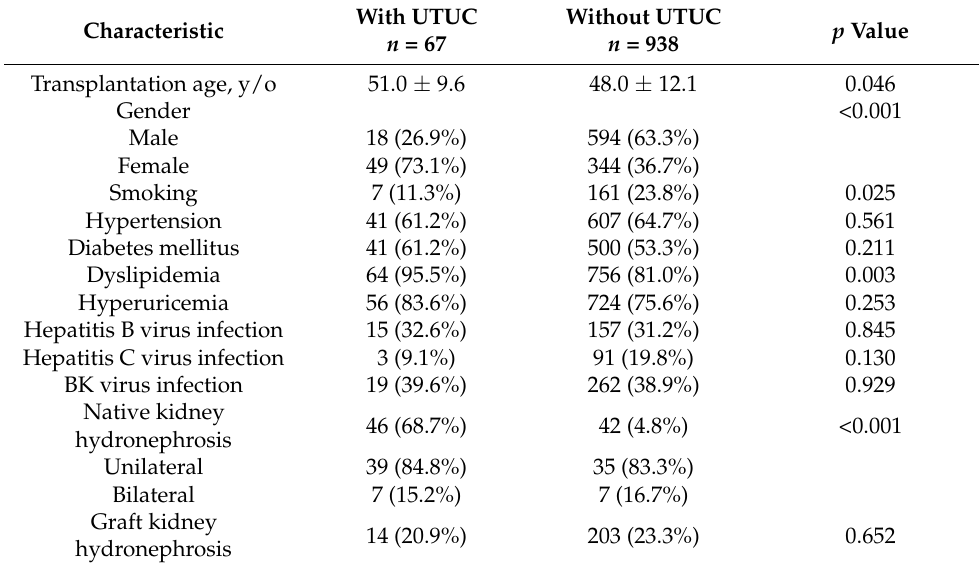
Table 2. Characteristics of KT patients with or without UTUC.